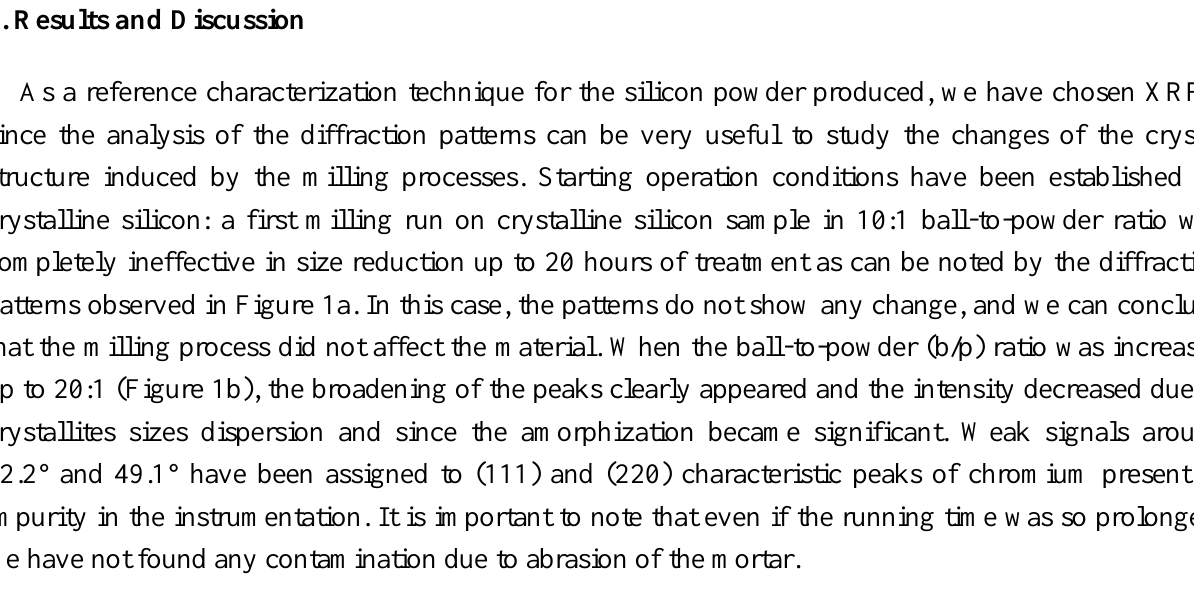
Figure 1. X-ray powder diffraction (XRPD) patterns for crystalline samples: ( a ) samples milled 0.1 h, 1 h, 10 h and 20 h with a 10:1 b/p ratio; ( b ) samples milled 0.1 h and 20 h with a 20:1 b/p